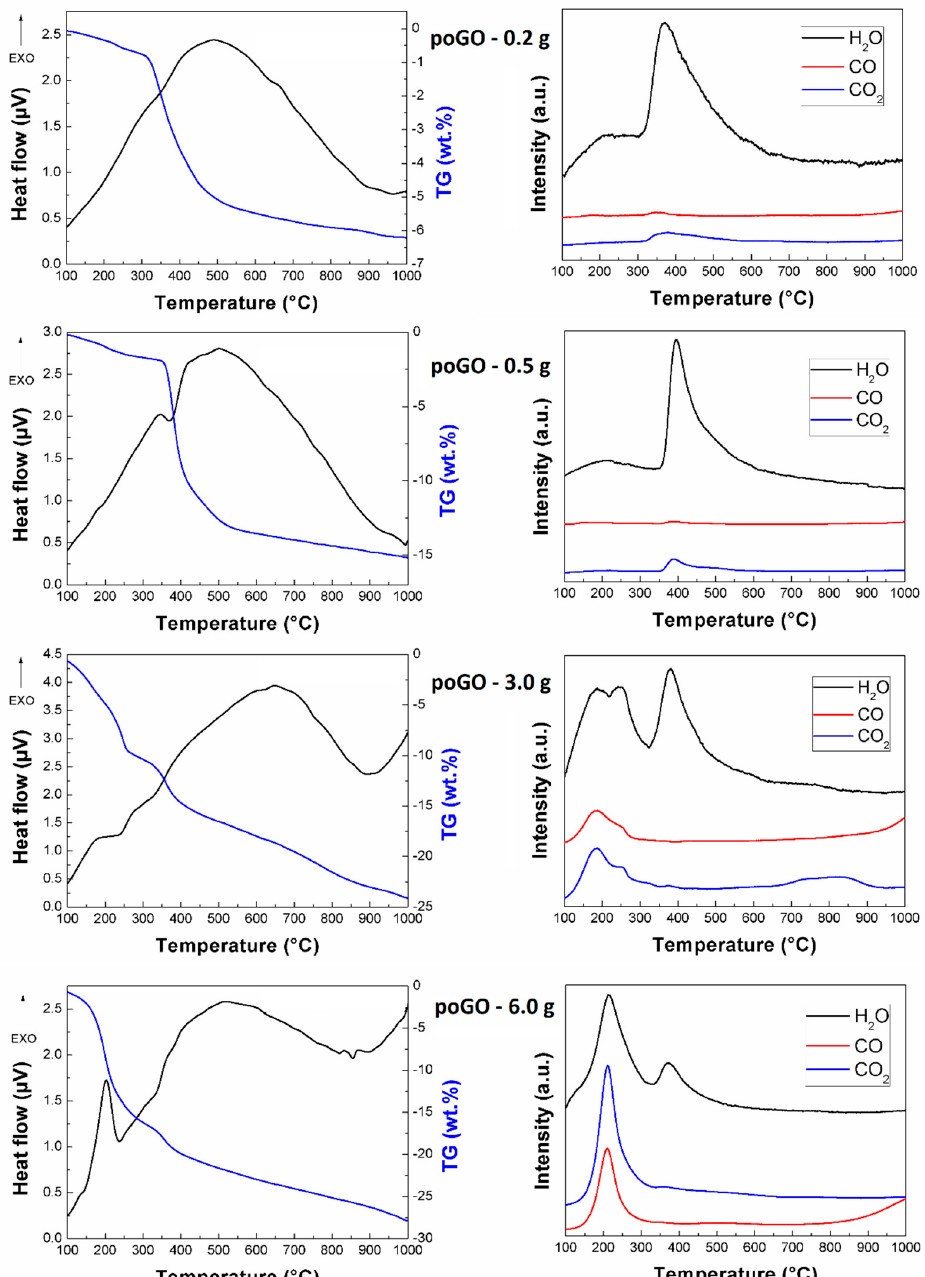
Figure 5. Thermal analysis of poGOs: heat flow and weight loss (left) and relative intensity of released gases (right).